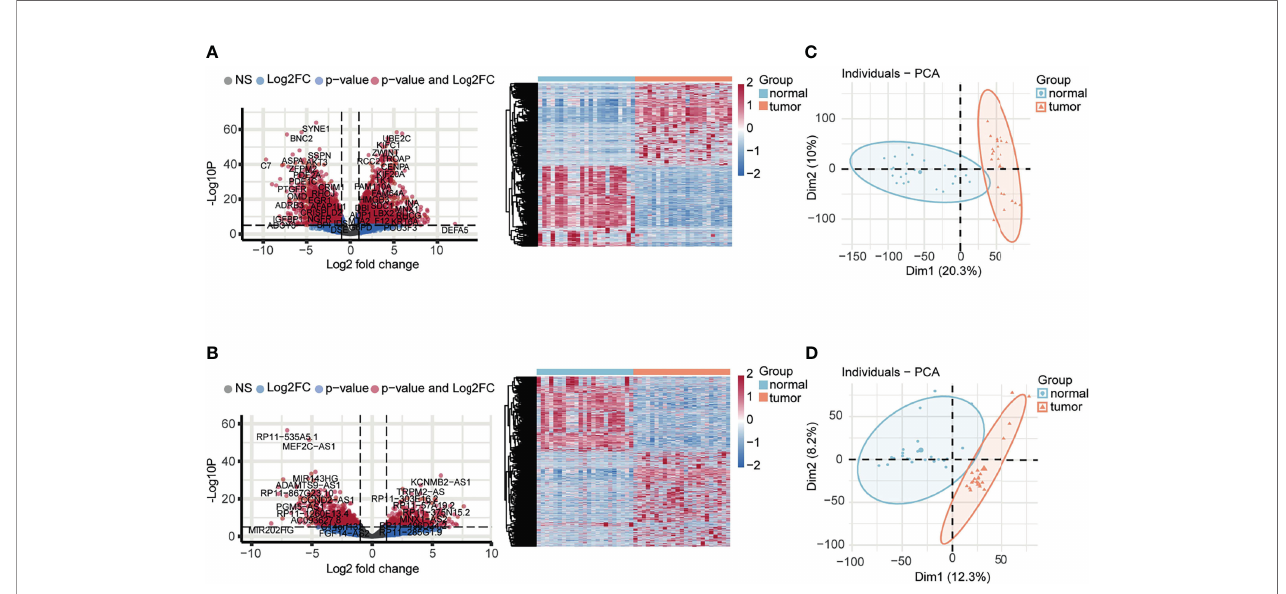
FIGURE 2 | Identi fi cation of DEGs associated with UCEC. (A, B) The volcano plots and heatmaps of DEmRNAs and DElncRNAs. 2569 DEmRNA strands (1295 upregulated and 1274 downregulated) and 1457 DElncRNA strands (733 upregulated and 724 downregulated) were identi fi ed at the threshold of FDR < 0.05 and | log2FC| > 2. (C, D) PCA plots of DEmRNAs and DElncRNAs showed that 23 tumors were clustered separately from their paired adjacent non-cancerous tissues.